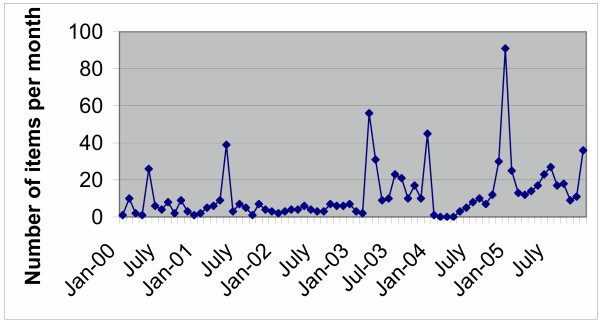
Newspaper items during 2000–2005 on secondhand smoke and licensed premises, in 12 New Zealand newspapers*. *Sunday Star Times, Dominion Post, Dominion, Evening Post, New Zealand Herald, Otago Daily Times (from 20 August 2002 only), Christchurch Press, Nelson Mail, Southland Times, Timaru Herald, Waikato Times, [Taranaki] Daily Times). Two of these (Dominion, Evening Post) were replaced in 2002 by the Dominion Post.